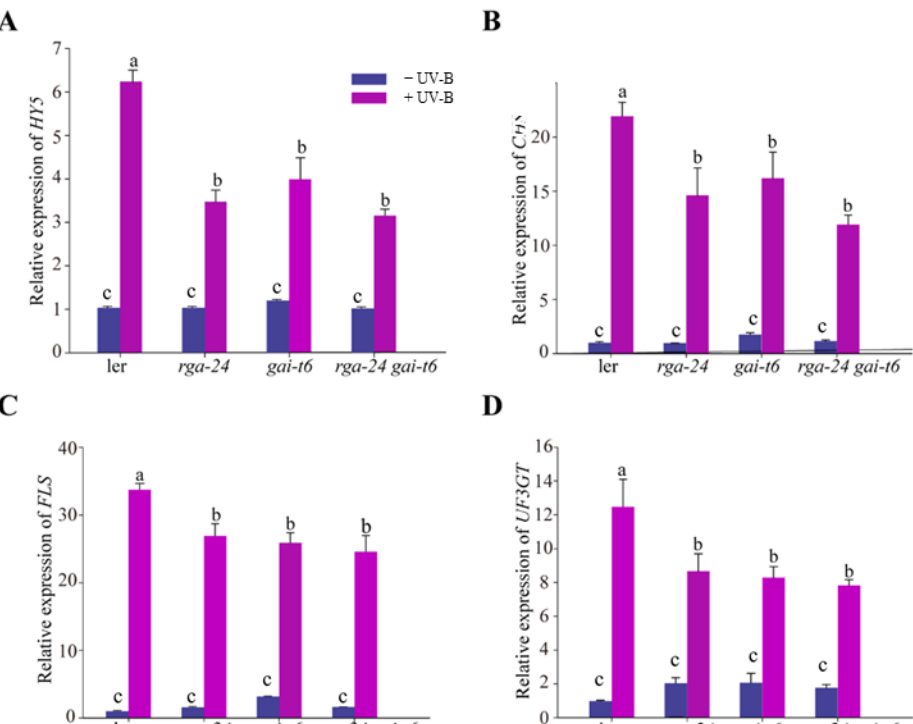
Figure 3. DELLA regulates the gene expression of the UV-B signaling pathway. ( A – D ) Quantitative reverse transcription PCR analyses of HY5 , CHS , FLS, and UF3GT expression, respectively, in the Ler , rga-24 , gai-t6, and rga-24 gai-t6 double mutants. Six-day-old constant white light-grown seedlings were transferred to UV-B for 1 h. The Actin2 gene was analyzed as an internal control. Error bars represent the SE of three biological replicates. The letters ‘a’ and ‘b’ indicate statistically significant differences between the gene transcription level of the indicated seedlings grown in the presence of UV-B radiation, “c” represents no significant difference between these columns, as determined by Tukey’s least significant difference test ( p < 0.05).